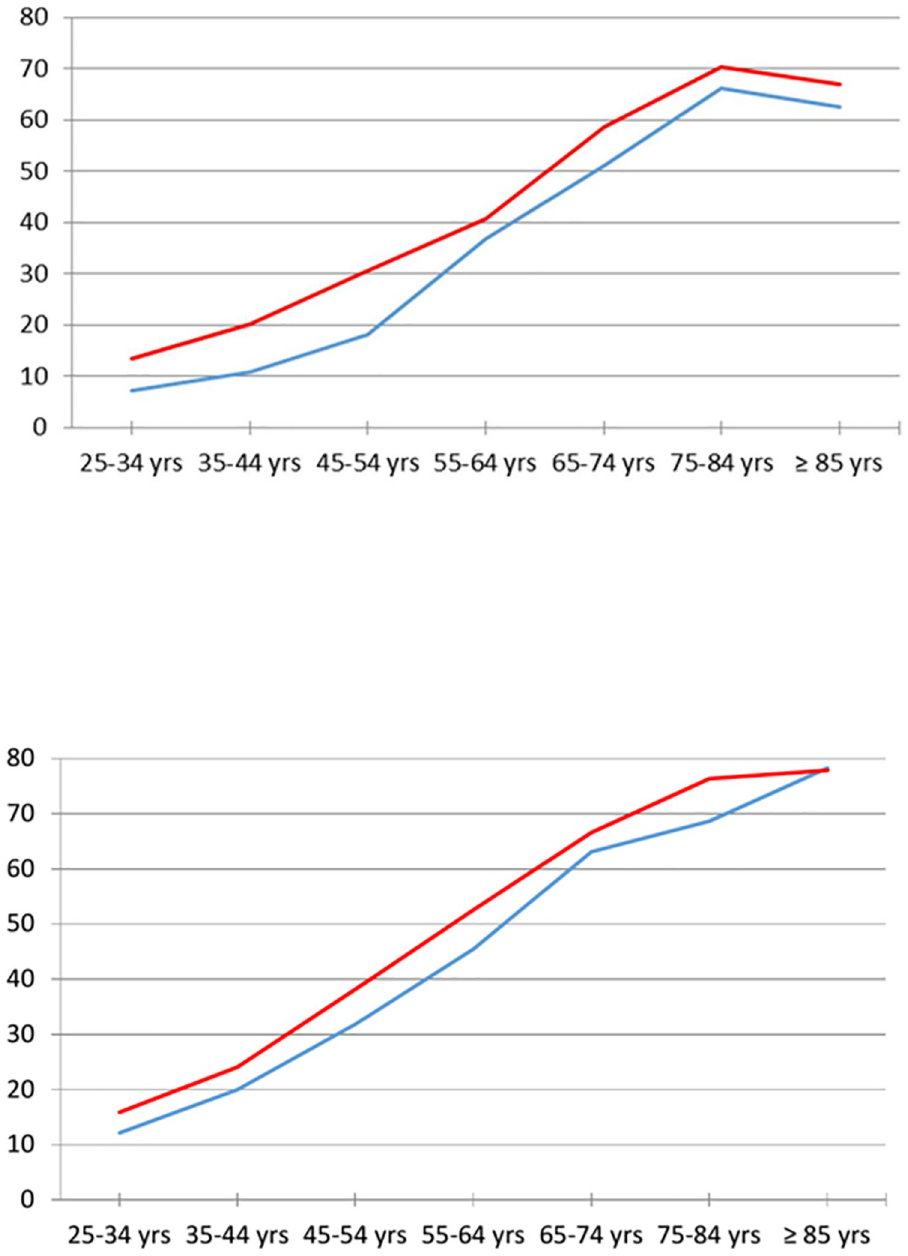
Fig 1. Age- and gender-specific prevalence of multimorbidity. Upper panel: 1 yr prevalence, Lower panel: lifetime prevalence. Ordinates represent frequencies in percentages. Red and blue lines indicate women (red) and men (blue).